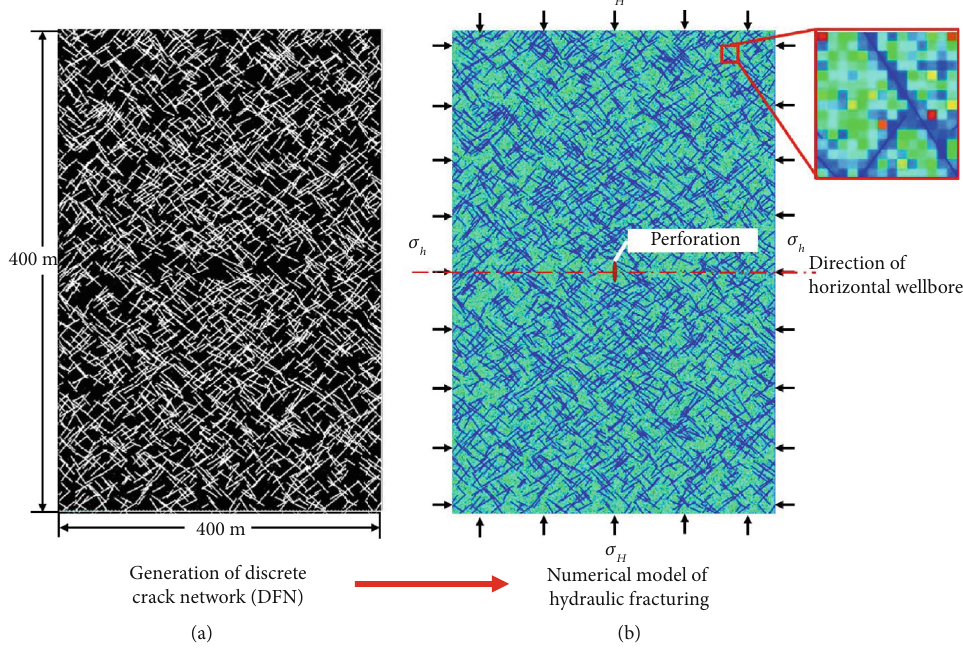
Figure 8: Two-dimensional numerical model of hydraulic fracturing in the fractured tight sandstone